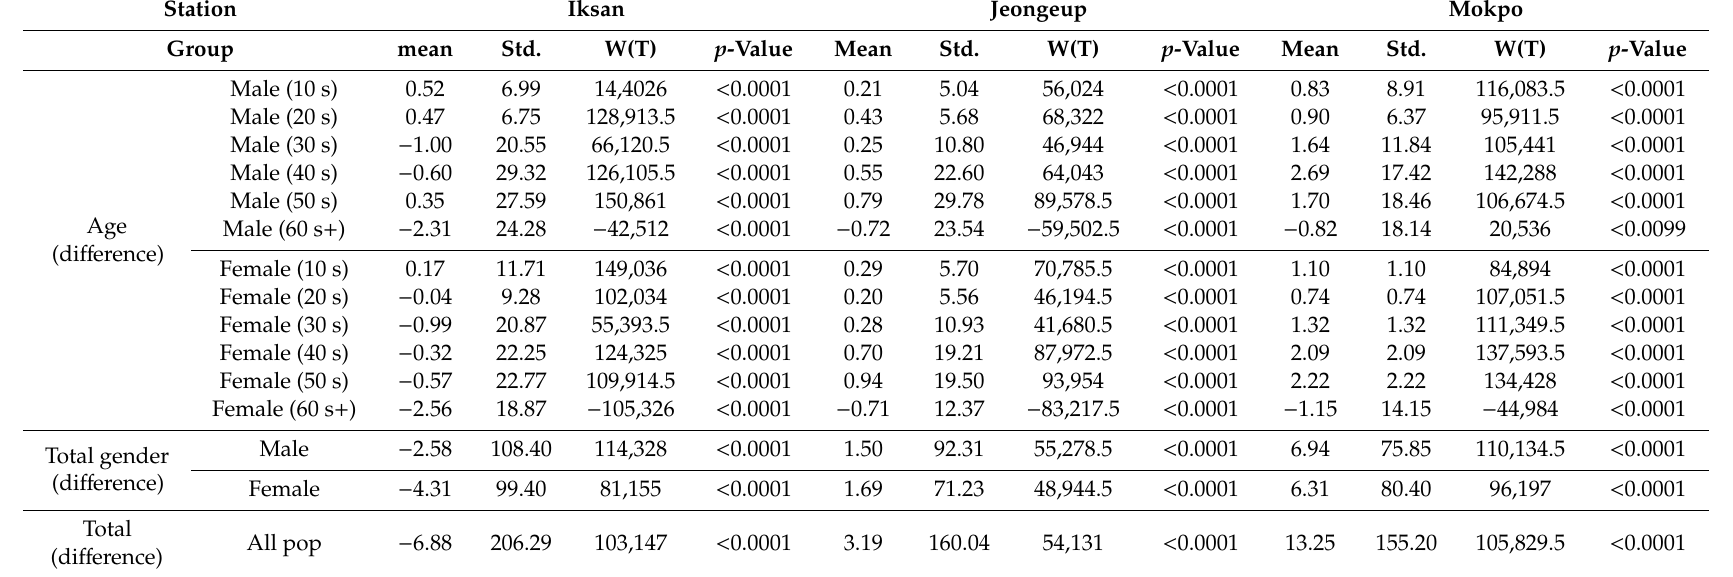
Table 5. Wilcoxon’s signed-rank test(W(T)) of di ff erences between mobile population before and after the HSR on